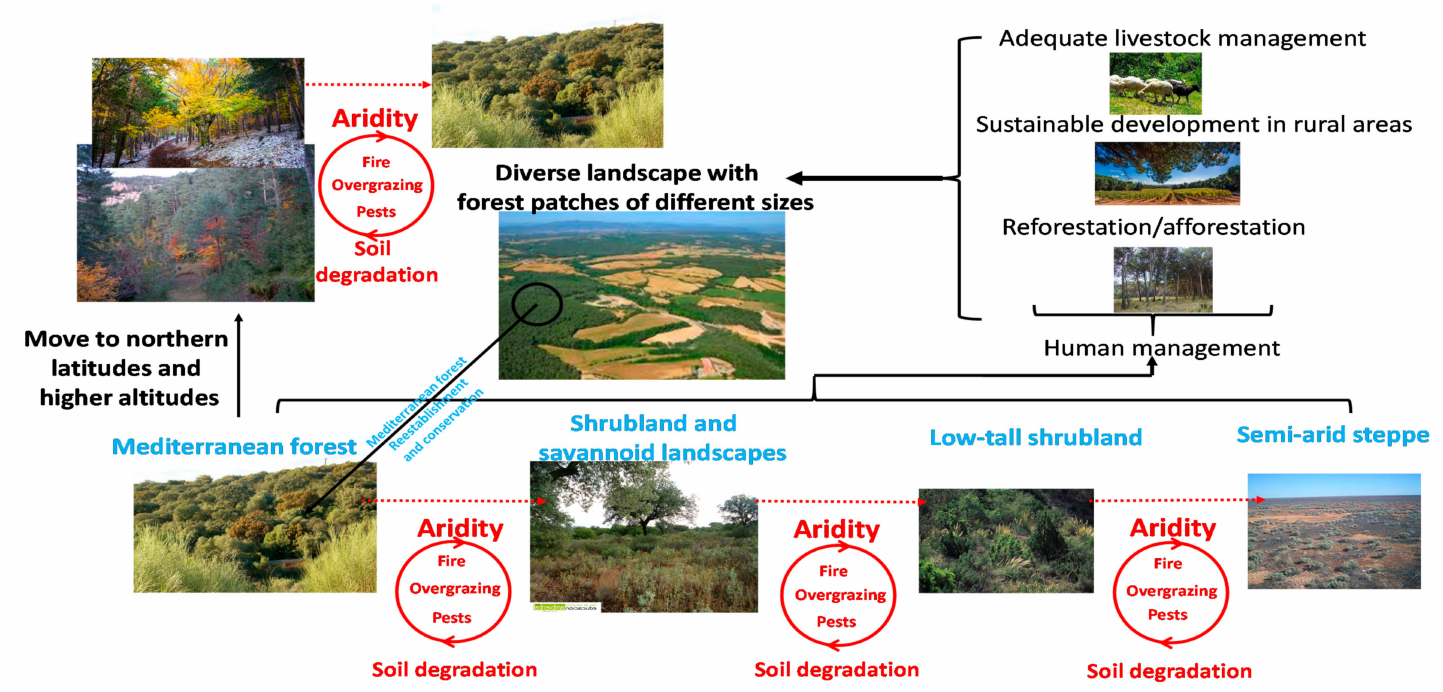
Figure 2. Schematic of the main processes of forest degradation to shrublands and steppes linked to soil degradation, aridity rise, and inadequate human management in the Mediterranean